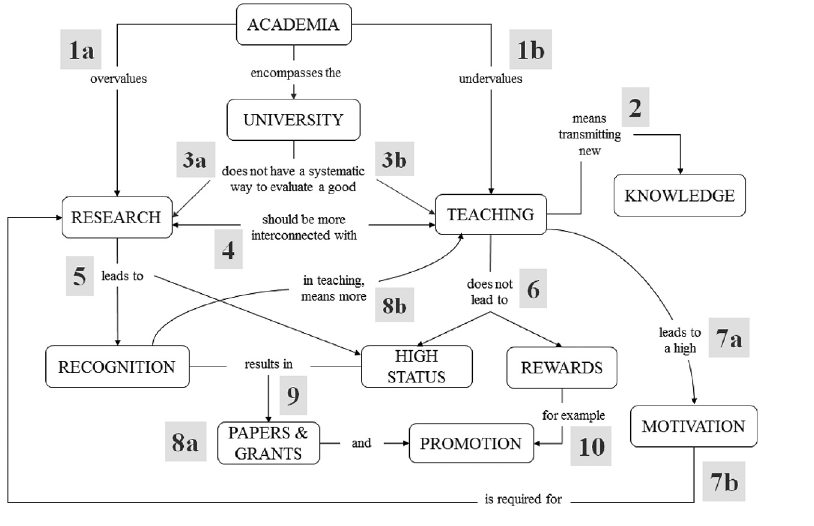
Figure 4. A concept map of